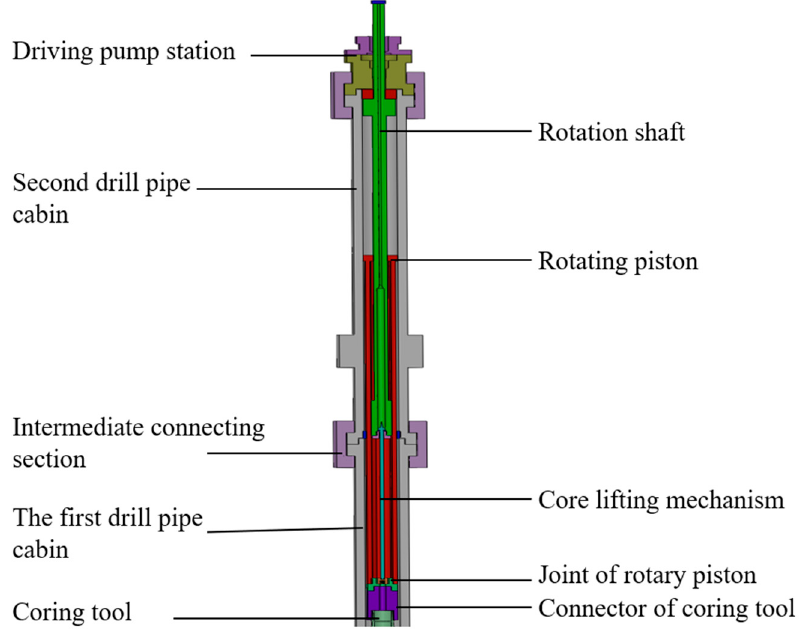
Figure 7. Structure of the lifting motion mechanism.